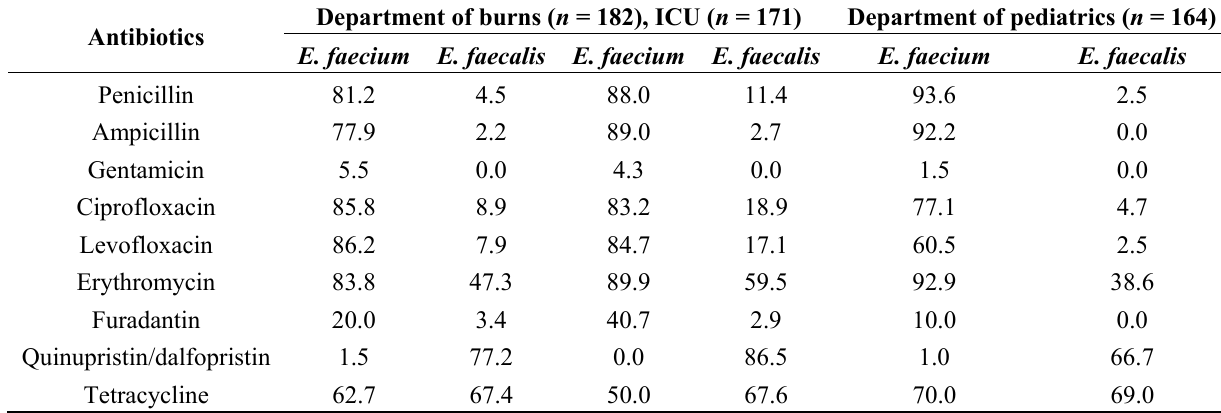
Table 6. Prevalence of antimicrobial resistance in Enterococcus species isolated from different departments of the hospital